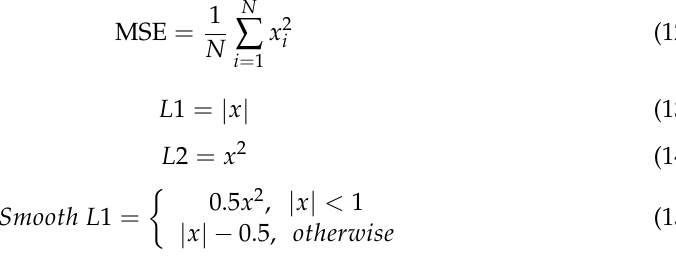
Table 1. The performance of different loss functions in the test